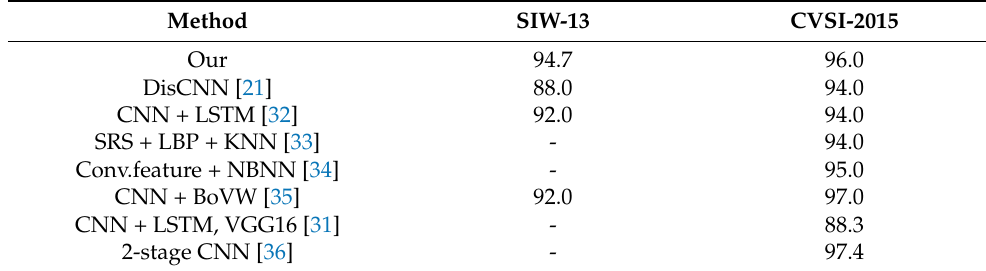
Table 7. Comparison accuracy (%) on two public script datasets.